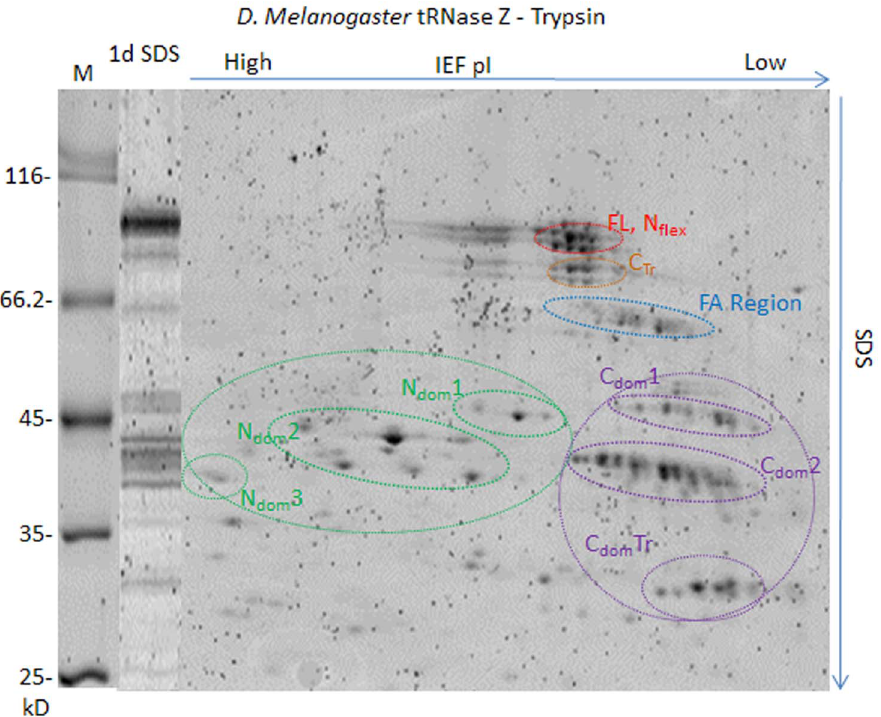
Figure 5. Two dimensional gel electrophoresis of D.melanogaster tRNase Z-trypsin polypeptides. A three min. digest like those illustrated in Figure 3 was electrophoresed on a first dimension isoelectric focusing tube gel. The second dimension SDS-PAGE was the same as in Figure 3.